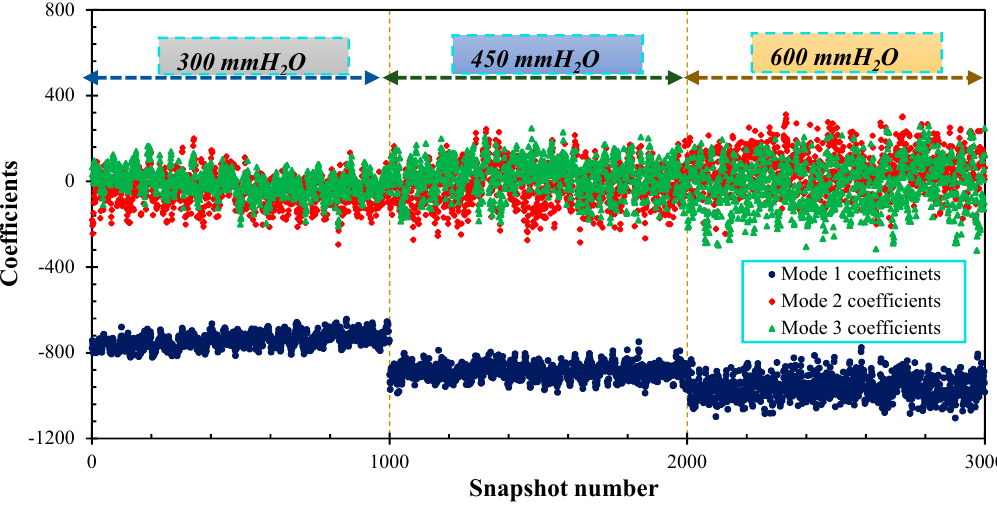
there was larger snapshot to snapshot variation at high pressure difference than lower one. This was attributed to the fact that higher pressure difference resulted in more air came into the cylinder with higher velocities and subsequently more turbulence.